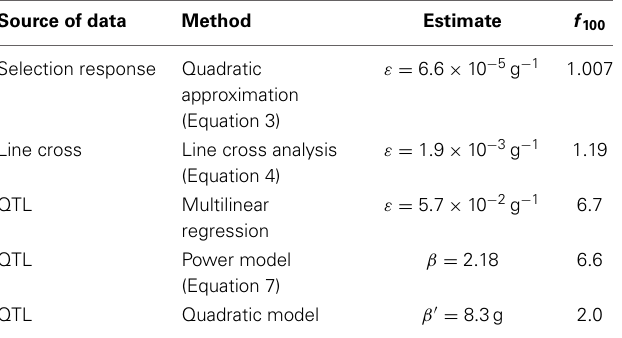
Table 2 | Summary of the directional epistasis estimates from different sources of data and different methods.